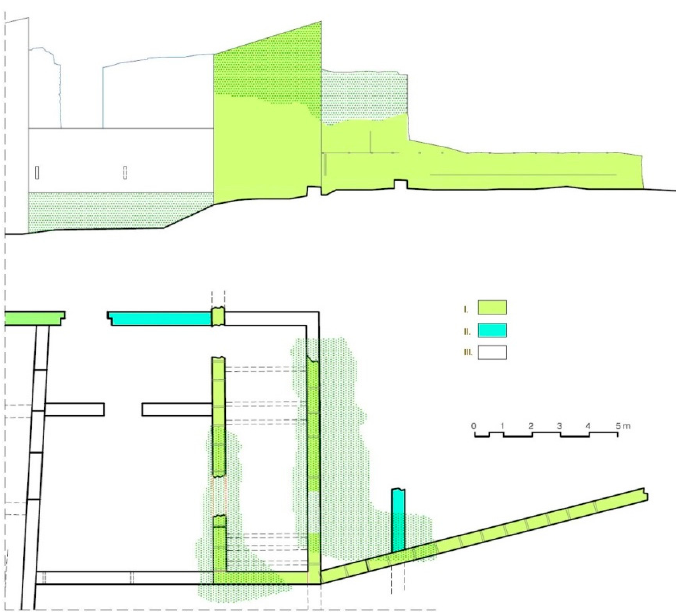
Figure 8. Construction techniques related to the temporary hypothesis. I : Tapia , II : Coursed rough stone masonry, III : Rubble stone masonry.